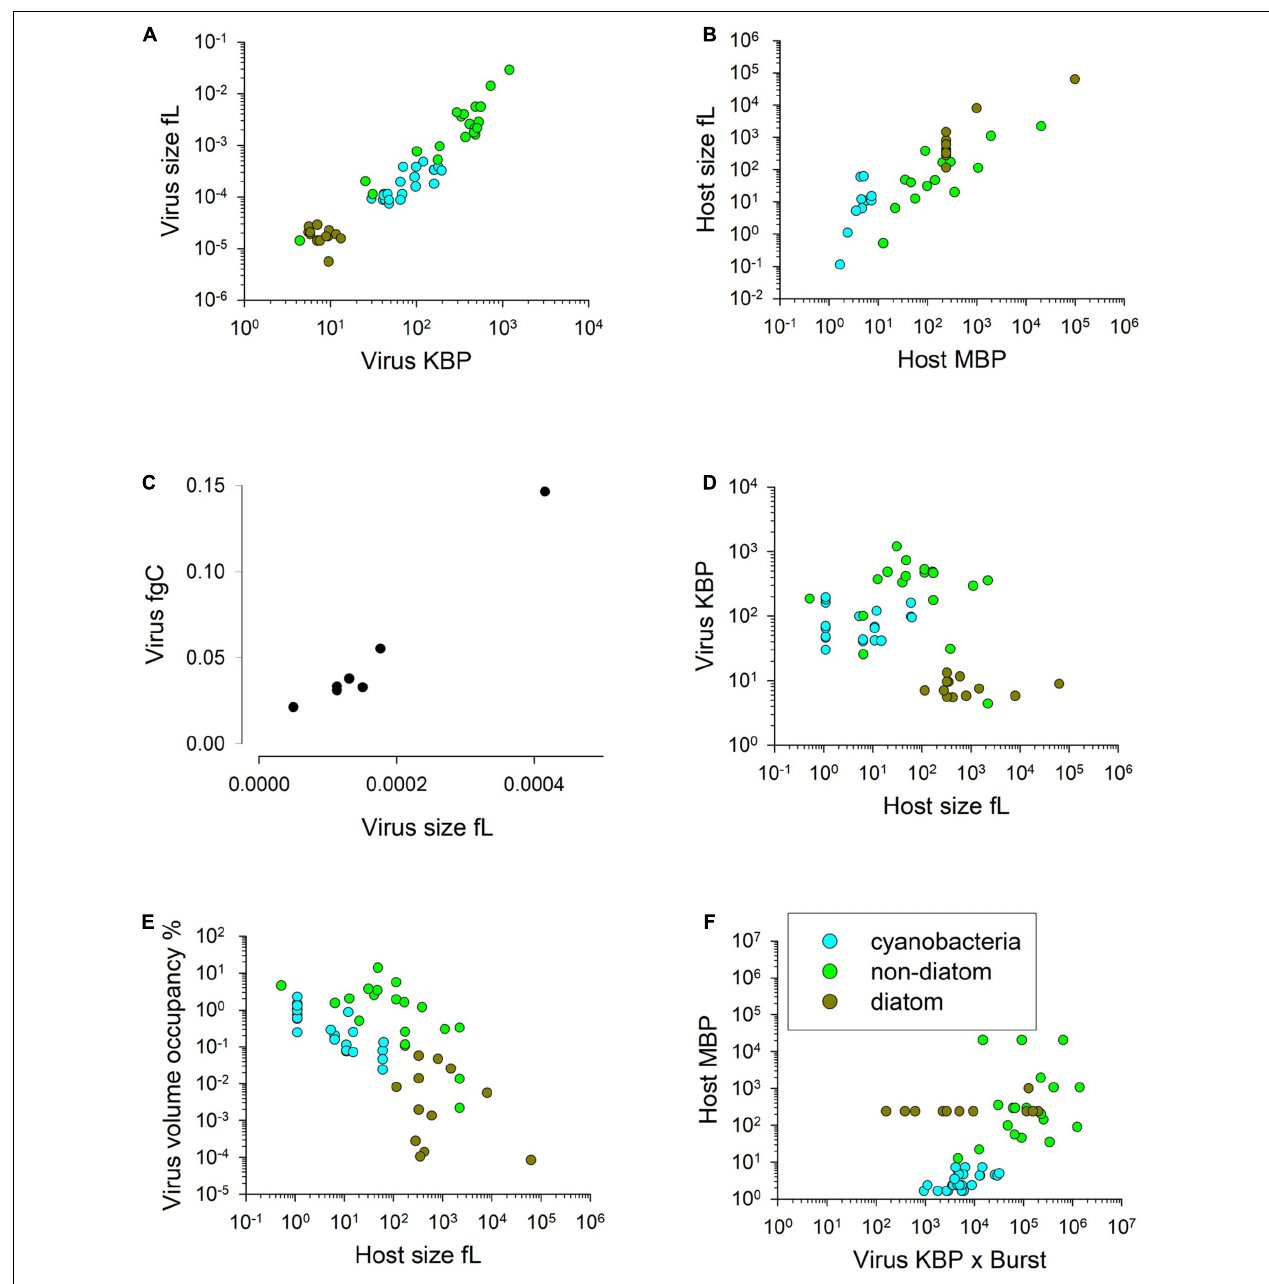
FIGURE 2 | Allometric relationships. Relationships between virus genome size (K base-pairs) and virus volume (panel A ; R 2 = 0.91, y = 1E6x 1 . 2278 ) and host genome size (M base-pairs) and host cell volume (panel B ; R 2 = 0.77, y = 0.7483x 0 . 9679 ). Relationship between virus volume and virus fgC (panel C ; R 2 = 0.89, y = 160.2x 0 . 9283 ). Panel (D) shows virus size (in terms of KBP) versus the size of their host (overall R 2 = 0.14). Panel (E) shows the relationships between host cell volume and virus progeny space occupancy (i.e., virus size x burst size) relative to host cell volume expressed at % (all data R 2 = 0.38, y = 1.625x − 0 . 656 ); the highest % occupancy is 14%; most are < 1% (i.e., 10 0 ). Panel (F) shows the lack of relationship between the product of (virus genome size) × (burst size) and host genome size ( R 2 = 0.26); even the highest demand of nucleic acids for viral replication equates to only ca. 0.1% of the host base pair size. Data transformed and manipulated from that collated by Edwards et al. (2020), except panel (C) from Jover et al. (2014).